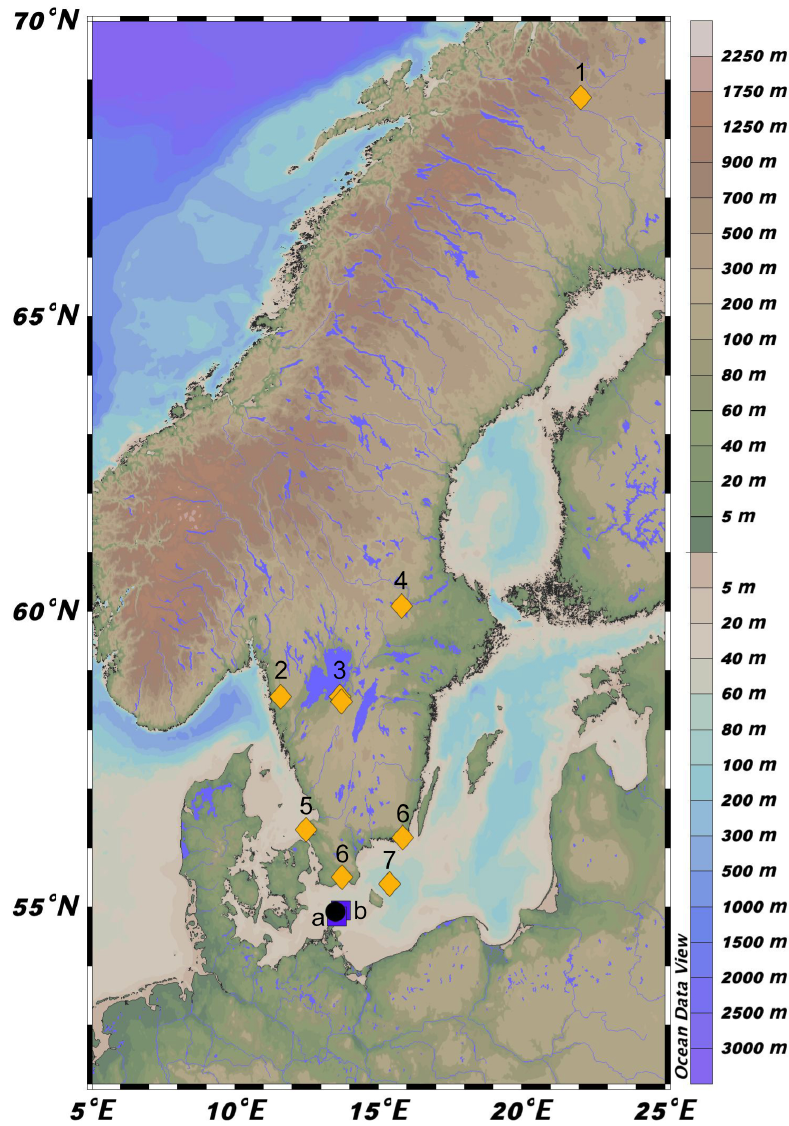
Figure 1. Location of 64PE410_S7 (black circle) in the southwestern Baltic Sea near the connection with the North Sea via the Danish Straits. Map was created in Ocean Data View (Schlitzer, 2021). Squares a and b represent the location of cores from Warden et al. (2016) used to construct the age model. Yellow diamonds correspond to regional pollen records. 1: Seppä and Weckström (1999), Seppä and Birks (2001); 2: Antonsson and Seppä (2007); 3: Hammarlund et al. (2003), Seppä et al. (2005); 4: Antonsson et al. (2006); 5: Berglund et al. (2008a); 6: Berglund et al. (2008b); 7: Andrén et al.